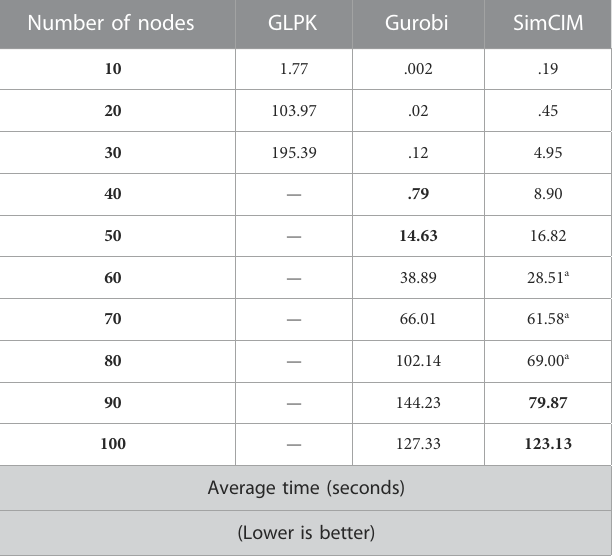
TABLE 2 Mean solution time depending on the number of nodes for GLPK, Gurobi, and SimCIM. The best result is highlighted in bold. Number of